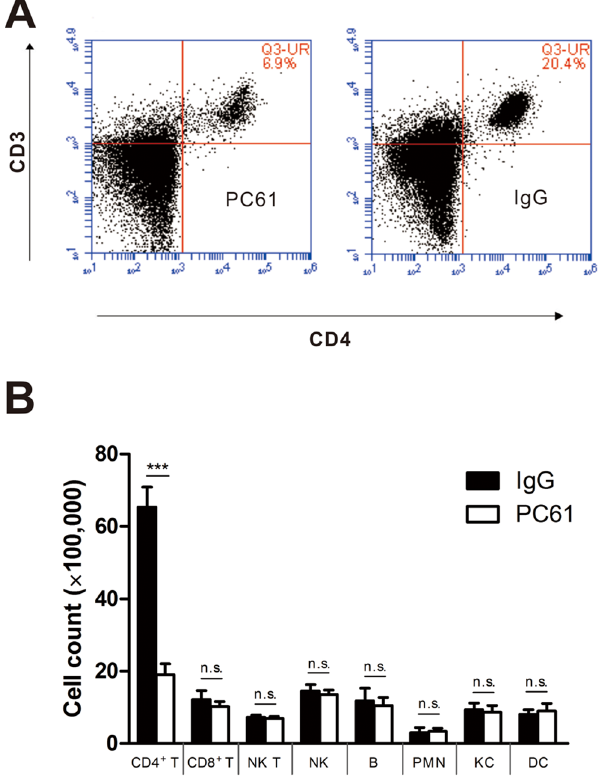
Figure 4. Anti-CD25 mAb administration reduced CD4 + T cells in mouse liver, not in blood or spleen. After one hour reperfusion, fleshly obtained hepatic nonparenchymal cells were isolated from PC61 or control IgG administrated C57Bl/6 mice. (A) Representative flow cytometry results from anti-CD3 and anti-CD4 stained hepatic nonparenchymal cells. (B) Total cells were gated on the 7-AAD 2 CD45 + before the FACS analysis, CD4 + (CD3 + /CD4 + ), CD8 + (CD3 + /CD8 + ) T cells, NK (CD3 – /NK1.1 + ), NK T(CD3 + /NK1.1 + ) cells, B cells (B220 + /CD19 + ), neutrophils (GR-1 + /CD11b + ), Kupffer cells (F4/80 low /CD11b + ), or den- dritic cells (F4/80 high /CD11b + ) were compared in each group. Data are mean values 6 SE; n=5 per group. (***p , 0.001).